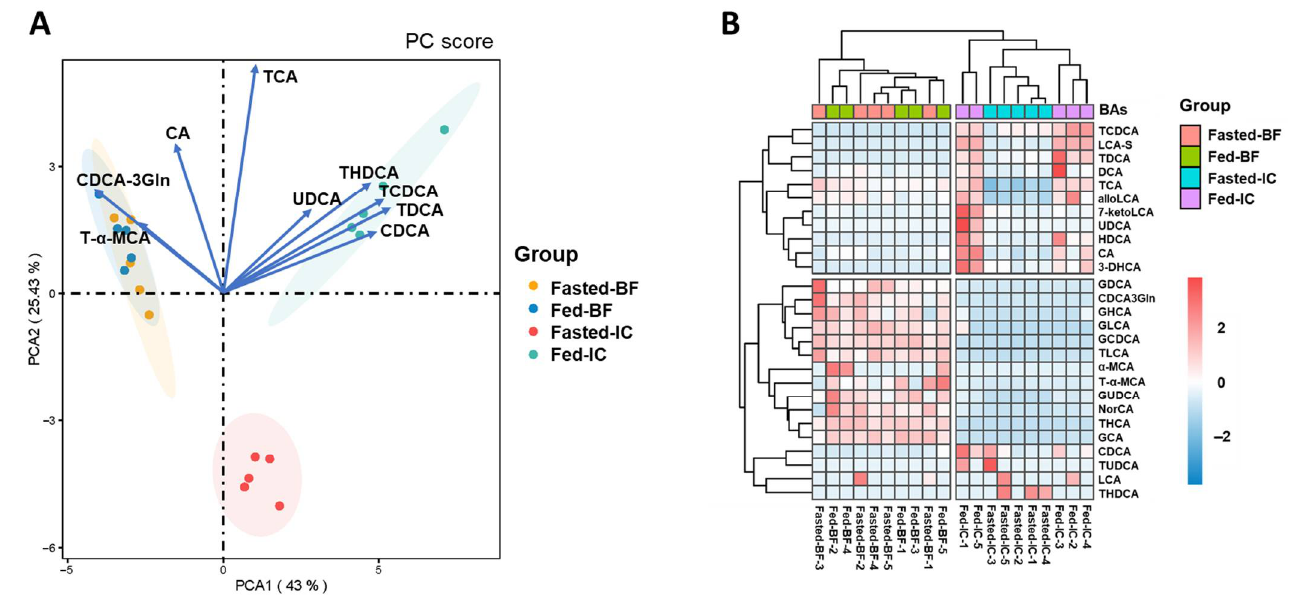
Figure 4. Comparisons of BA profiles in large yellow croaker ( Larimichthys crocea ). ( A ) Principal component analysis (PCA) of BA profiles with each of the 27 BAs (all the BAs that appeared in large yellow croaker). The 95% confidence interval is marked by oval circles. The contributions of the top five BAs are indicated by arrows (the projection of the arrows on the coordinate axes shows the contribution). ( B ) Heatmap depicting a multiclass analysis of the four groups of BA profiles. The intensity of the color indicates the expression level of BAs (dark red, high expression; sky blue, low expression). Fed-IC, IC of fish fed regularly; Fasted-IC, IC of fish fasted for 24 h; Fed-BF, BF of fish fed regularly; Fasted-BF, BF of fish fasted for 24